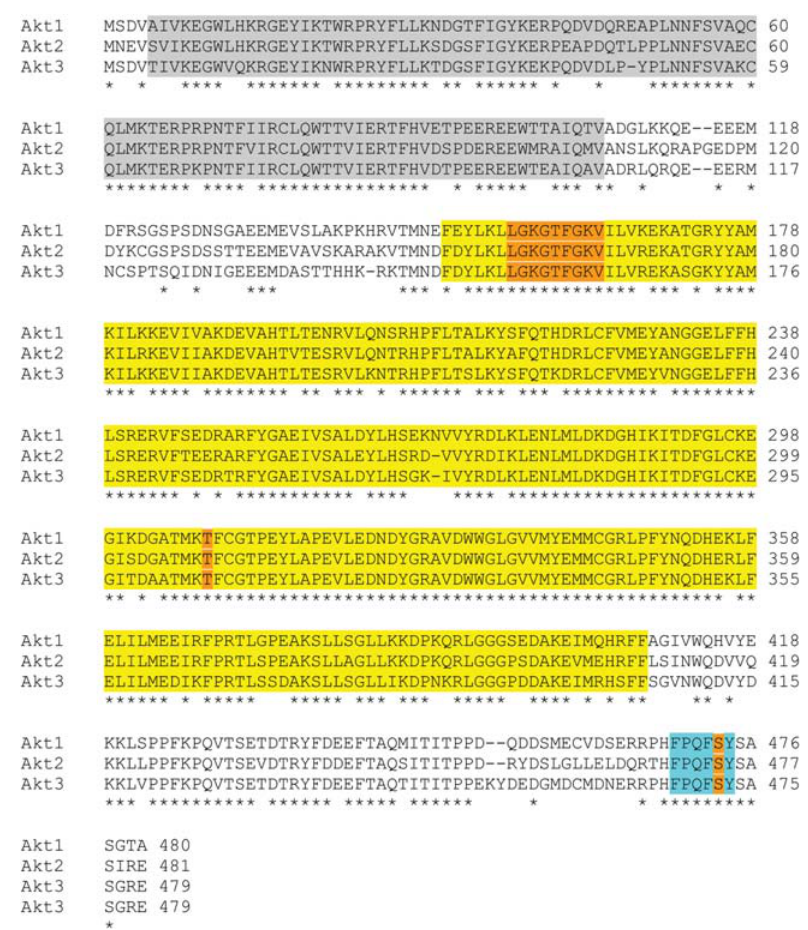
Figure 1 The alignment of Akt1 (19), Akt2 (20), and Akt3 (20) amino acid sequences is shown. Alignment was carried out using the Clustal W software (21). Highlighted boxes in gray, yellow, and blue denote the PH domain, kinase domain, and the C-terminal hydrophobic motif (FXXFSY among AGC kinases), respectively. Highlighted boxes in orange denote the